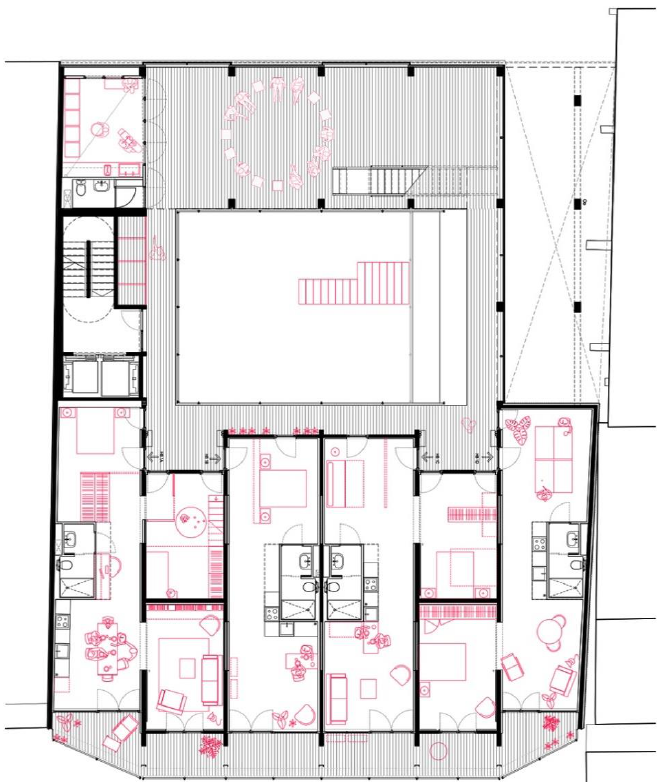
Figure 2. La Borda, first-floor plan. To the north is a large sharing space, the laundry, shared toilet and storage space. To the south are the dwelling units. Source: Courtesy of Lacol.